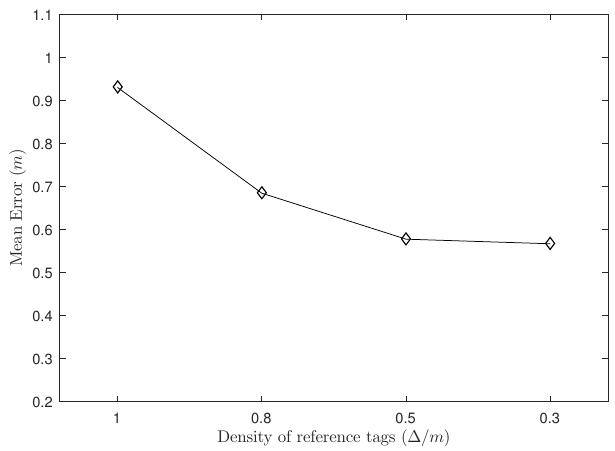
Figure 3. The Influence of Density of Reference Tags.